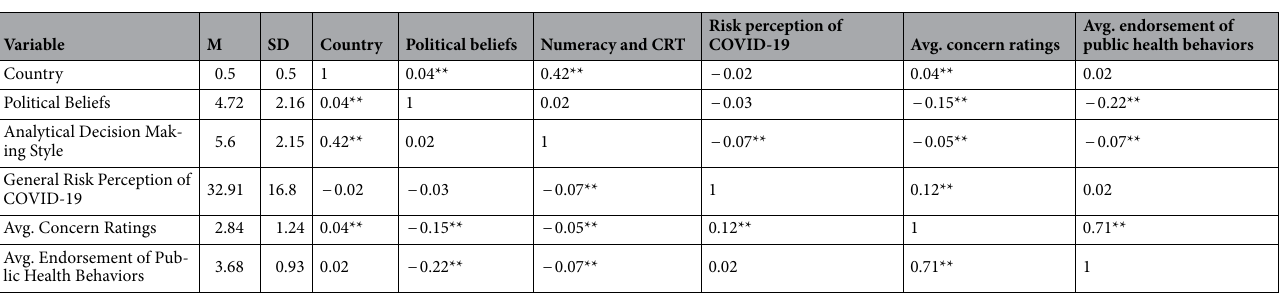
Table 1. Descriptive and correlation table. N = 551. Country (0 = USA, 1 = Canada), Political Beliefs (1 = Very Liberal, 9 = Very Conservative), Analytical Decision Making Style measured using numeracy and CRT, General Risk Perceptions of COVID-19 (see “Method” section), Avg. Concern rating is the average across all concern ratings in the experiment, Avg. Endorsement of Public Health Behaviors is the average across all endorsement of public health behaviors in the experiment.